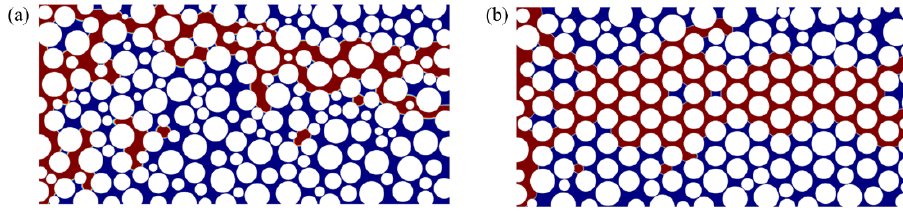
Figure 19. CO 2 saturation distribution after 2 PV CO 2 injection (red and blue regions represent CO 2 and oil, respectively). ( a ) K = 7.7192 × 10 − 11 m 2 ; ( b ) K = 1.5487 × 10 − 10 m 2 .